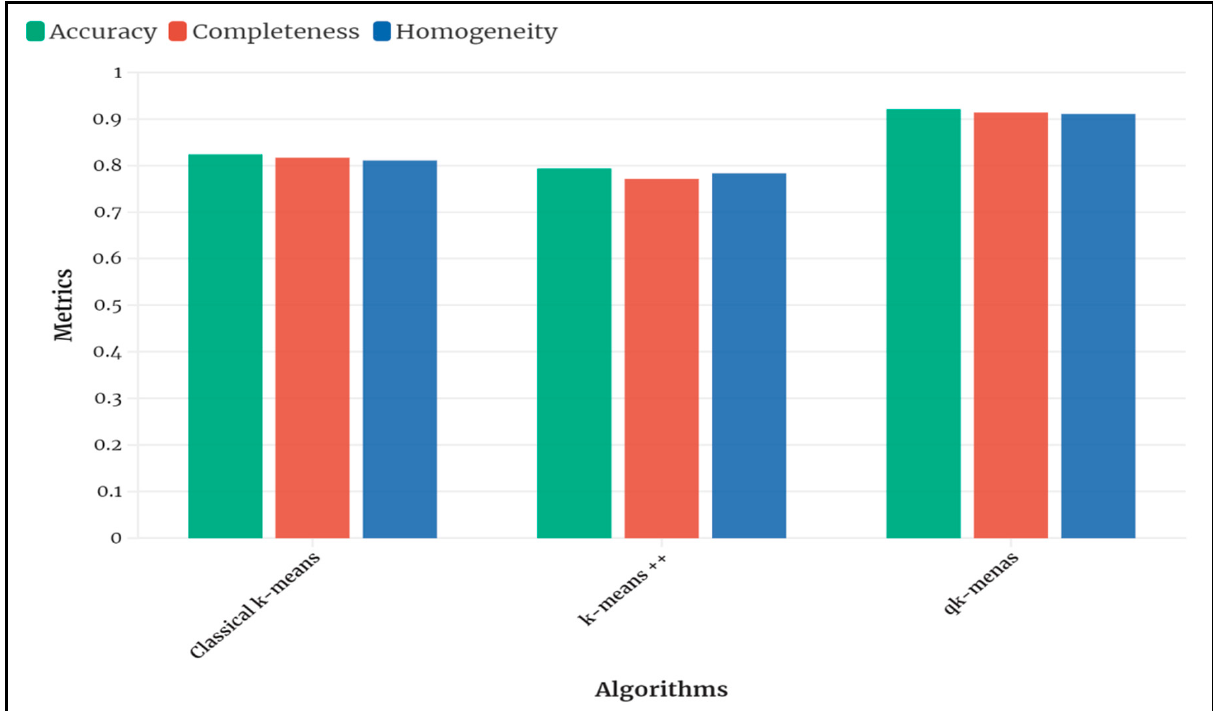
Figure 12. Results from the various classical and classical-quantum clustering algorithms, includ- ing the k-means, k-means++ and QK-means algorithms, are displayed in the bar graph using the cardiovascular dataset. Three metrics—accuracy, completeness and homogeneity—are employed.